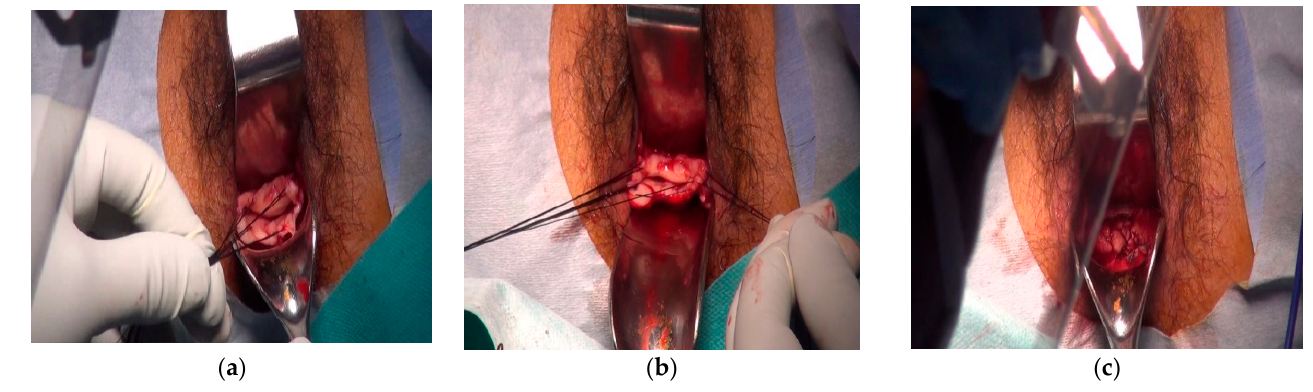
Figure 1. Vaginal cuff creation was performed as described in a previous report [19]. ( a ) Pull the needle from the vaginal wall and inject adrenaline saline solution for 400,000 times; ( b ) Make an incision with Metz Mechenbaum 3 o’clock 9; ( c ) Peeling the vaginal wall with a thickness of ≥ 2 cm. The vaginal cuff creation technique is shown in Supplementary Video S1.